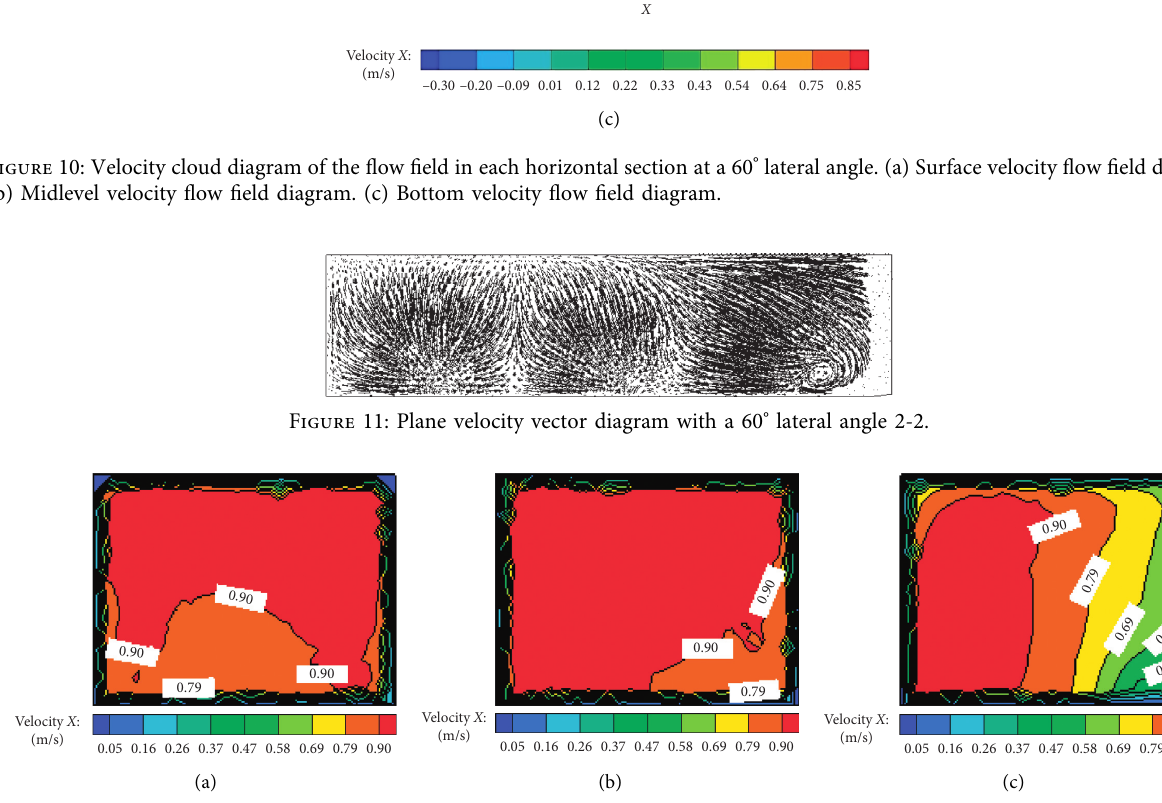
Figure 12:1-1 planar velocity cloud diagram with a 60 ° bending angle in the lateral direction (unit: m/s). (a) 3# passage. (b) 2# passage. (c) 1# passage